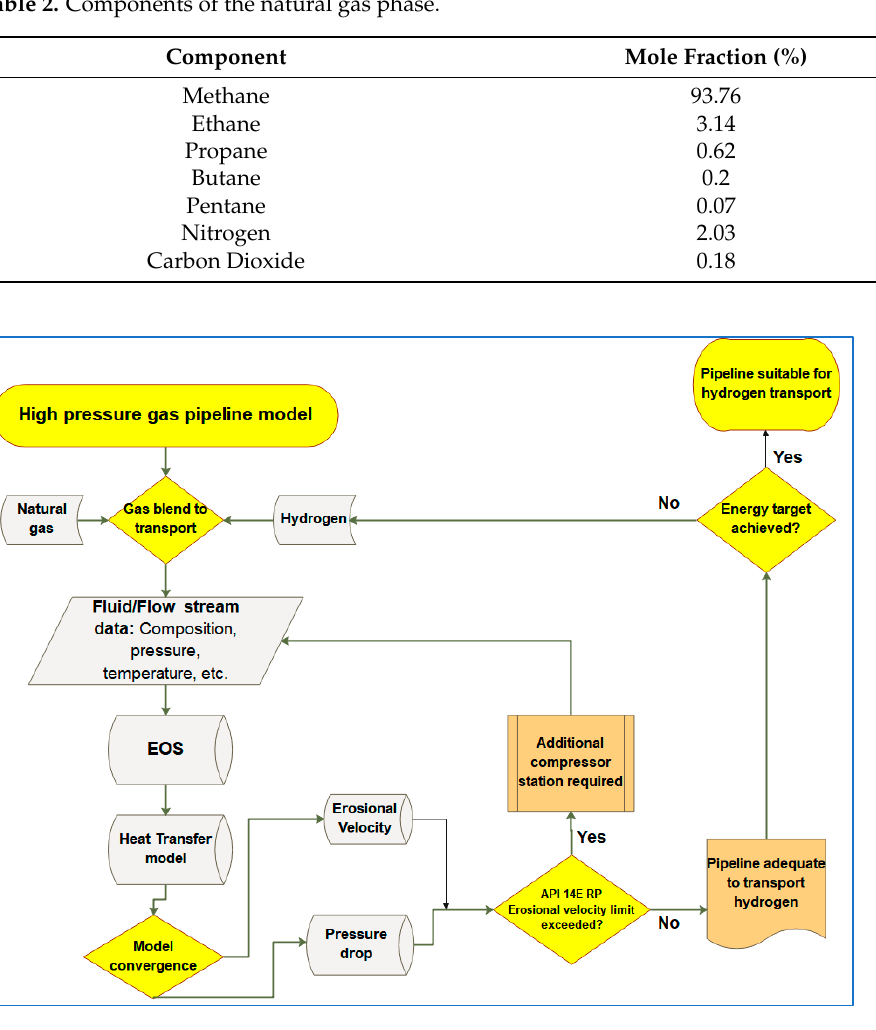
Figure 4. Simulation flow chart for pipeline transportation of hydrogen and natural gas blends.